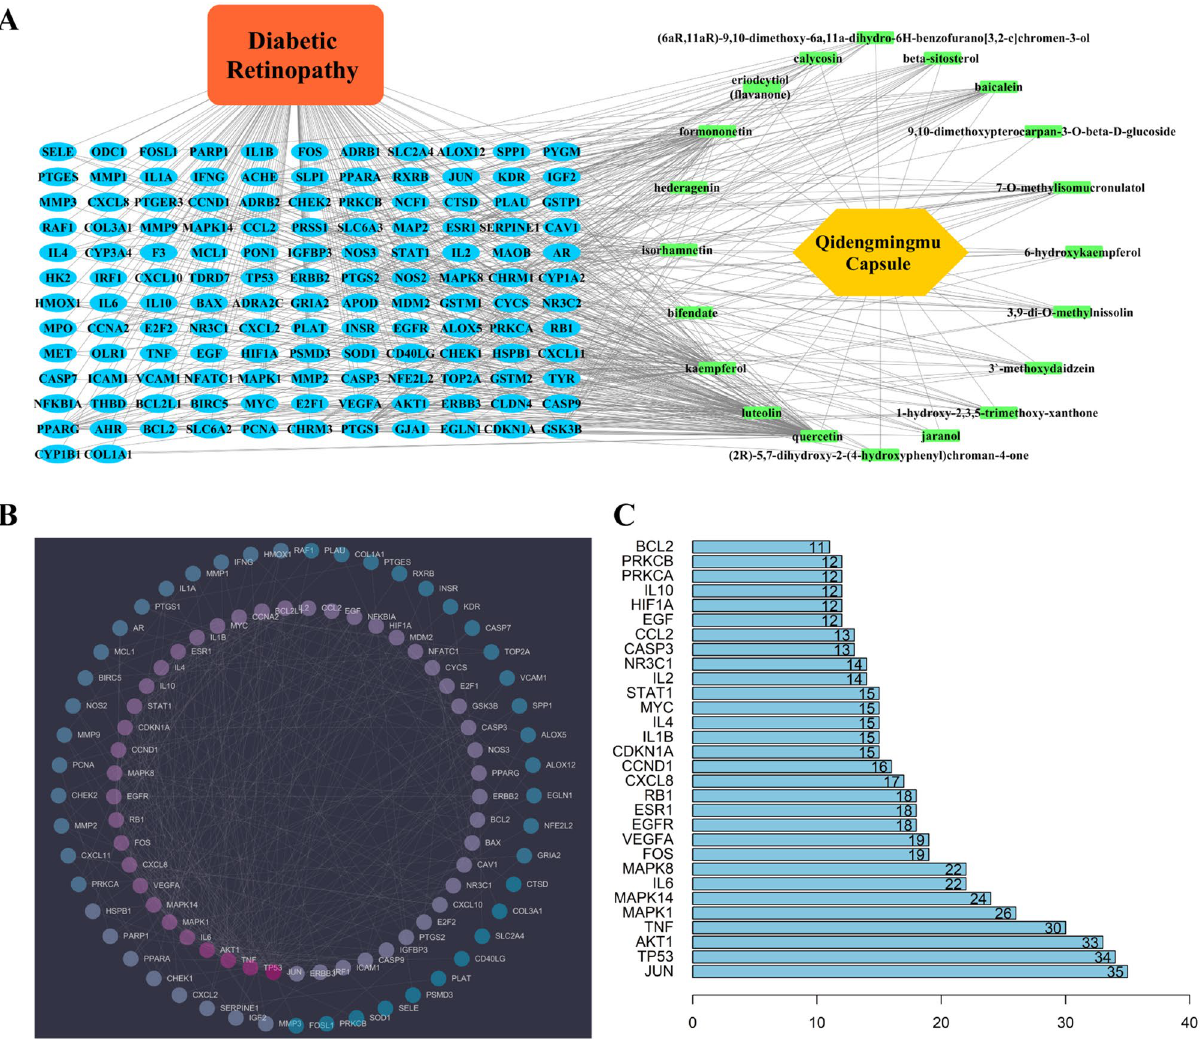
Figure 2. Active ingredient-DR Target Network and PPI Network based on QC-DR common targets. ( A ) Active ingredient-DR target network: the active ingredients of QC (20 ingredients) are shown as green rectangular nodes, and the common targets (134 targets) are shown as blue oval nodes. ( B ) PPI network of common targets. The nodes are ordered by degree according to the color from violet (high) to blue (low). ( C ) Key proteins in the PPI network and the correlated degrees. The X-axis represents the degree of the target, and the Y-axis represents the gene symbol of the